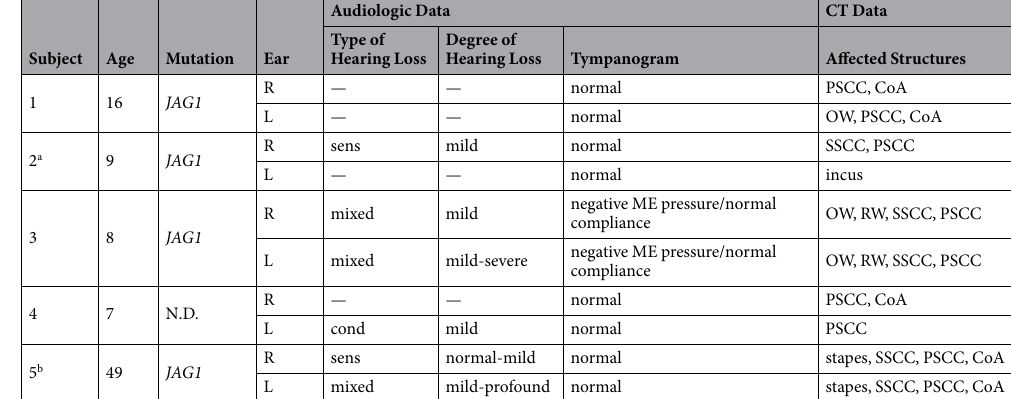
Table 2. Hearing tests and CT data of selected subjects from the 2011 and 2014 Alagille Alliance meetings. Cond = conductive hearing loss; CoA = cochlear aperature; CT = computed tomography; L = left; ME = middle ear; N.D. = not determined OW = oval window; PSCC = posterior semicircular canal; R = right; RW = round window; sens = sensorineural hearing loss; SSCC = superior semicircular canal;- = within normal limits. a Previous test had showed conductive hearing loss in right ear. b This subject has mutations in JAG1 but had not previously been diagnosed with